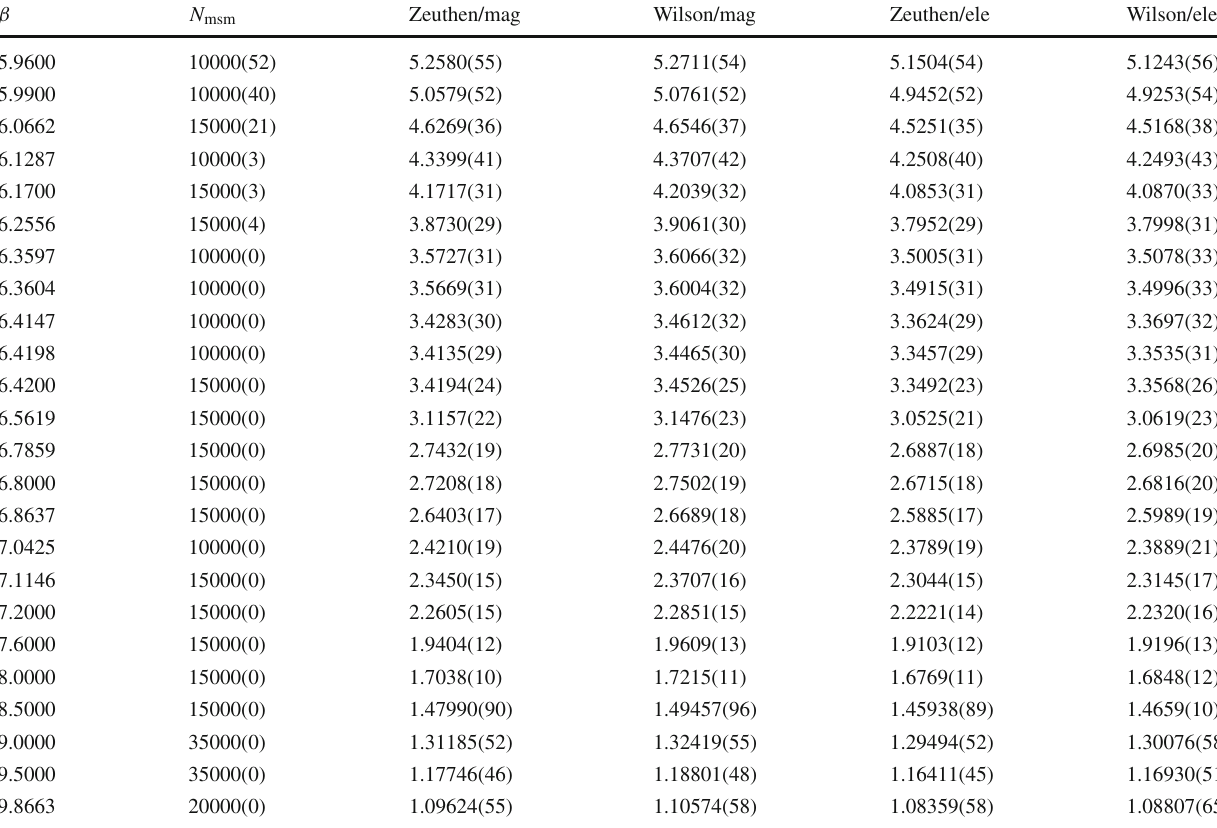
Table 16 GF coupling data for L / a =